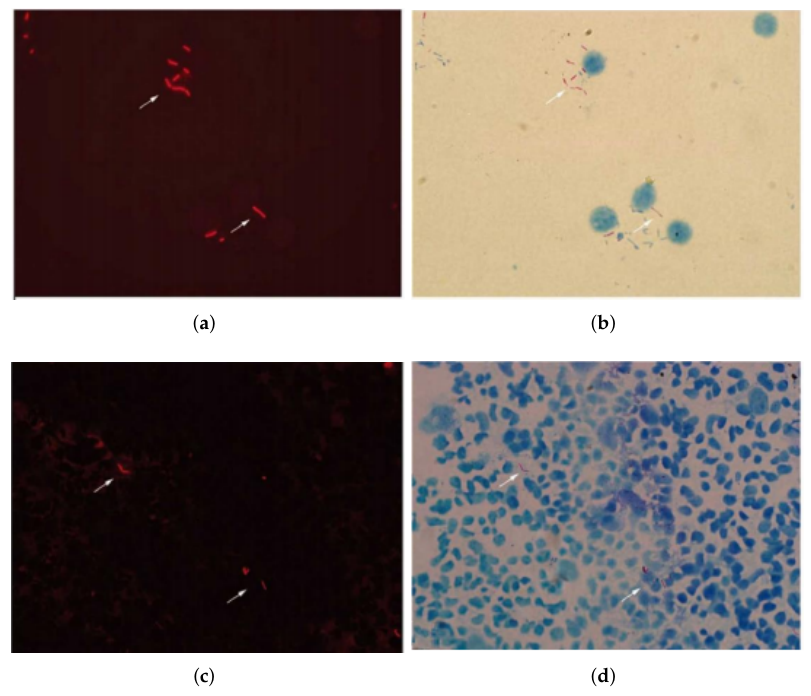
Figure 1. ( a , c ) Images of a slide acquired using fluorescence microscopy with Fuchin stain ( × 1000 magnification), and ( b , d ) images of the same slides acquired using conventional microscopy ( × 800